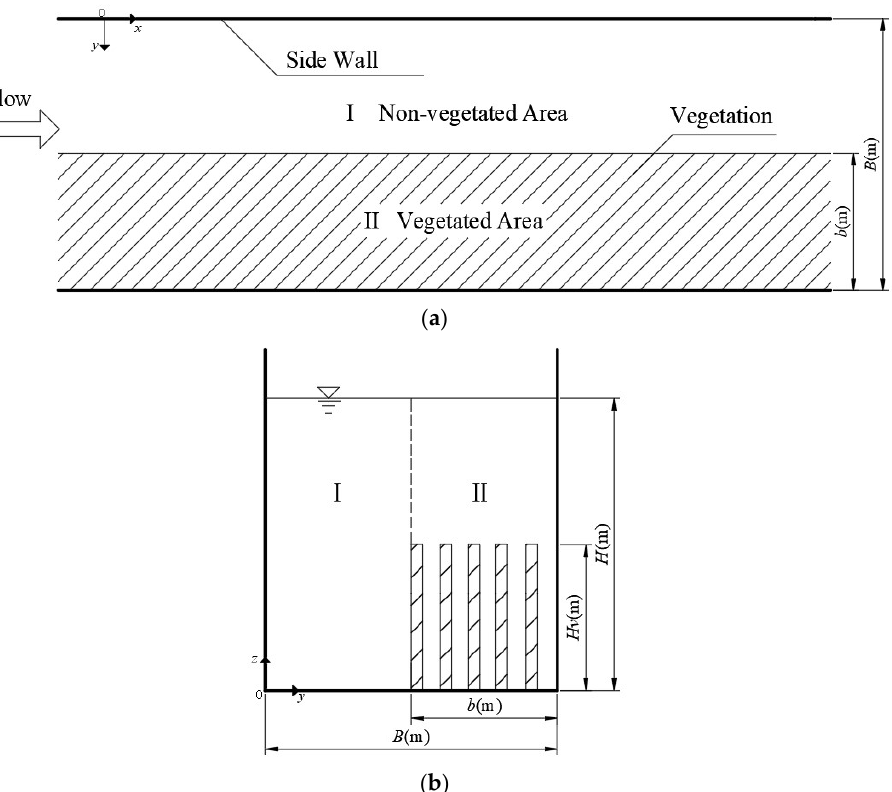
Figure 1. Layout of the vegetation in the flume. ( a ) Top view arrangement; ( b ) arrangement of the cross-section profile. Here, b represents the width of the vegetated area, B represents the width of the flume, H v represents the height of the vegetation, and H represents the flow depth. Ⅰ and Ⅱ represent the non-vegetated area and the vegetated area, respectively.